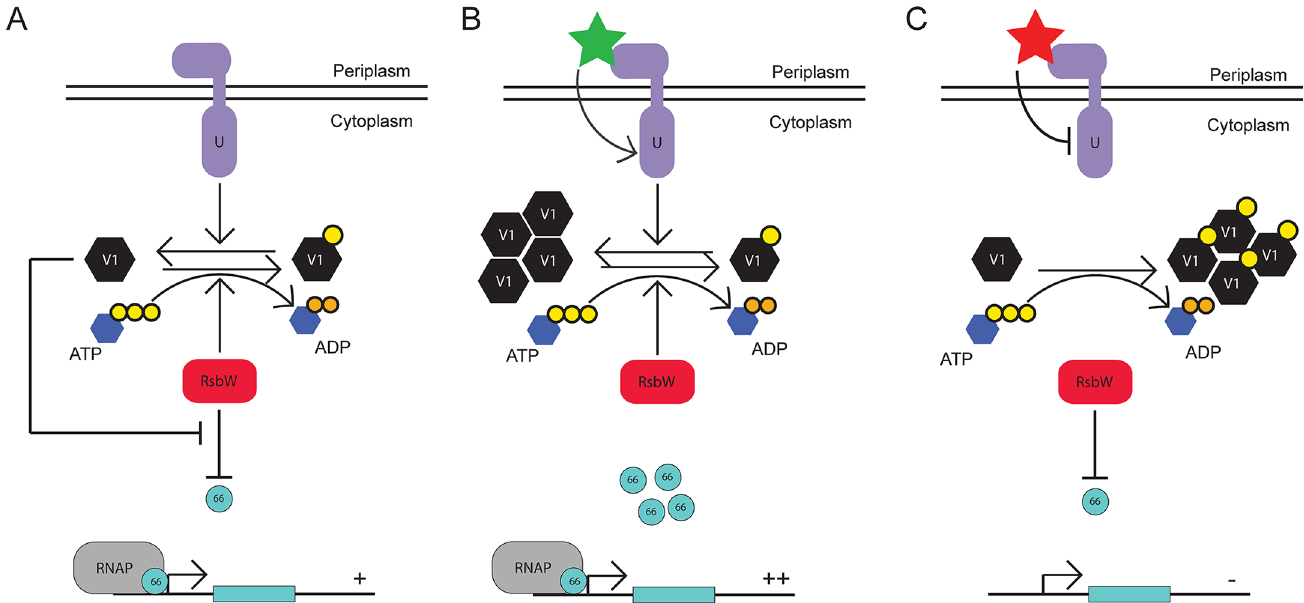
Fig 6. Proposed model for the function of the Rsb regulatory system in Chlamydia . Under steady-state conditions, the expression levels and activies of RsbU Ct (purple), RsbV1 (black), and RsbW Ct (red) provide an equilibrium in which σ 66 availability is ample for normal growth and development (A). Upon an accumulation of active ( i . e . non phosphorylated) RsbV1 via increased expression or increased activity/expression of RsbU Ct , the equilibrium of RsbW Ct function shifts away from the anti-sigma factor role, allowing increased transcription of σ 66 -promoted genes (B). Upon the decreased availability of active RsbV1 (either through reduced expression or reduced RsbU Ct expression/activity), the equilibrium of RsbW Ct function is driven towards the anti-sigma factor function, limiting the amount of σ 66 that is available for association with the core RNAP complex (C).